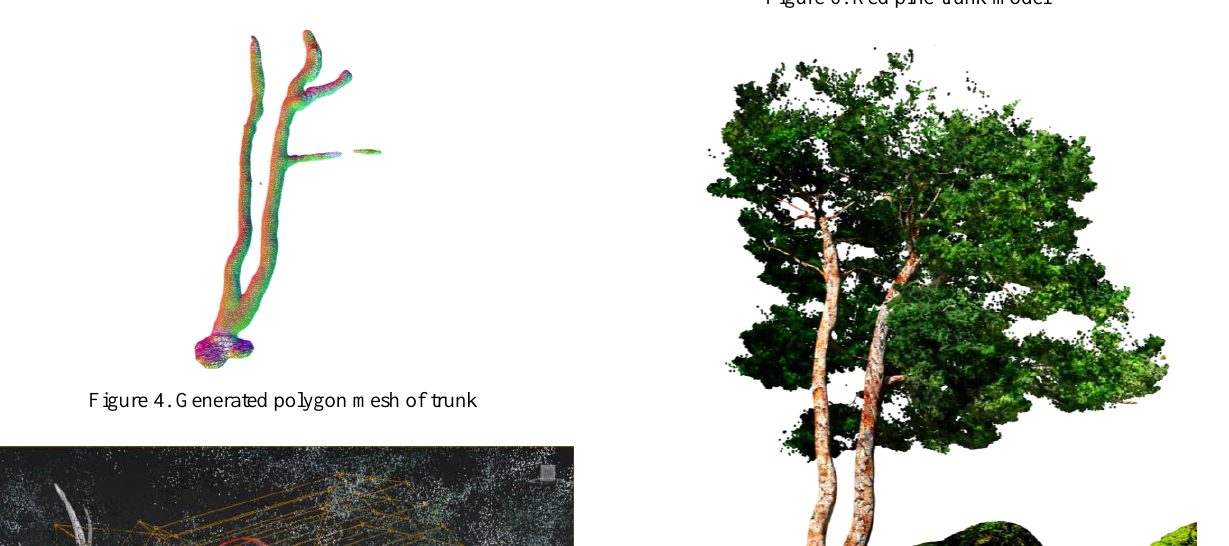
Figure 6. Red pine trunk model